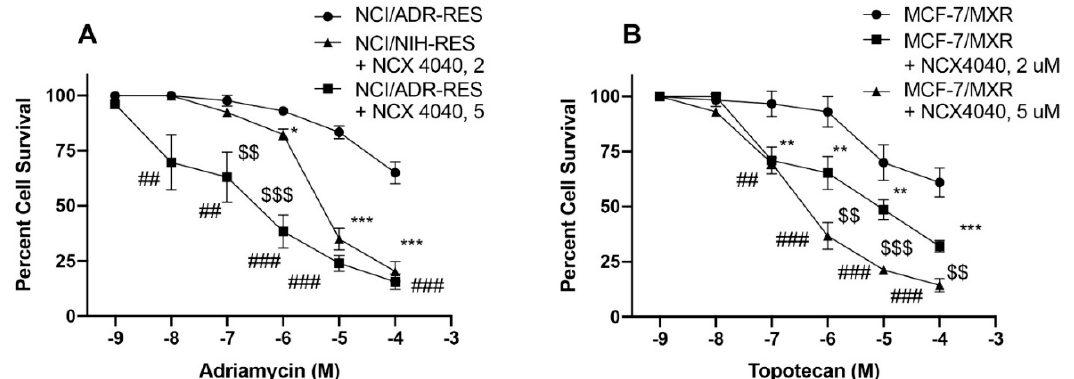
Figure 7. Reversal of adriamycin ( A ) and topotecan ( B ) resistance by NCX4040 (2 µM, and 5 µM) in NCI/ADR-RES and MCF-7/MXR cells, respectively. *, ** and *** p values 0.05, 0.005 and 0.001, respectively compared to concentration-matched samples. ##, ### p values <0.005 and <0.001 compared to drug alone and $$ and $$$ p values <0.005 and <0.001 compared to concentration-matched drug in the presence 2.0 µM NCX4040.